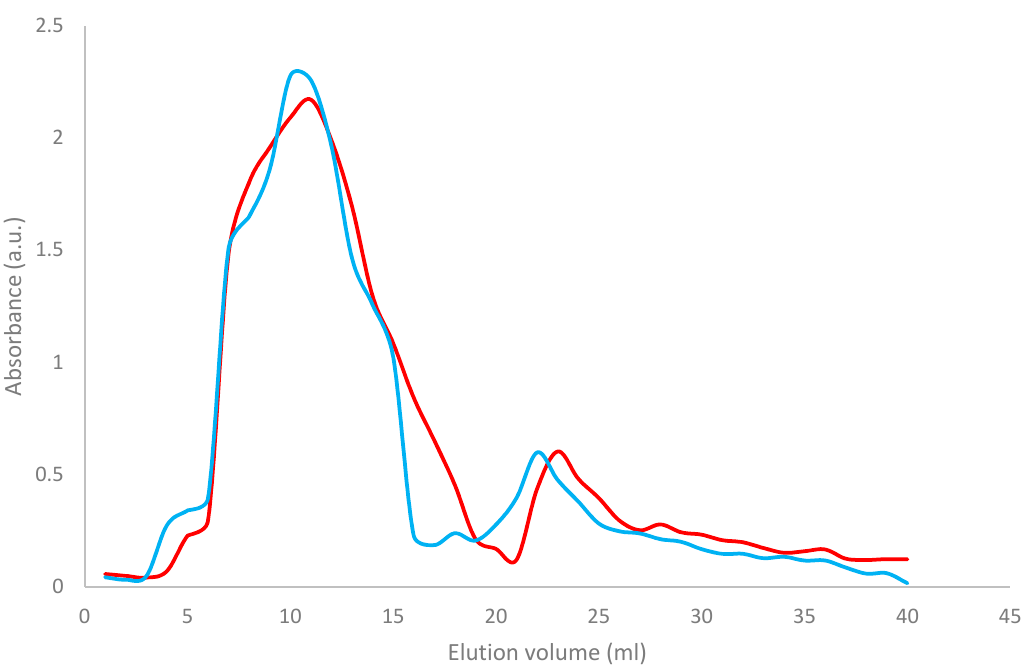
Figure 6. Elution profile of the Wt and Mut2 8S α globulin after hydrophobic interaction chromatography (HIC) using Biorad butyl toyopearl. Red—Wt 8S α globulin; blue—Mut2 8S α globulin.